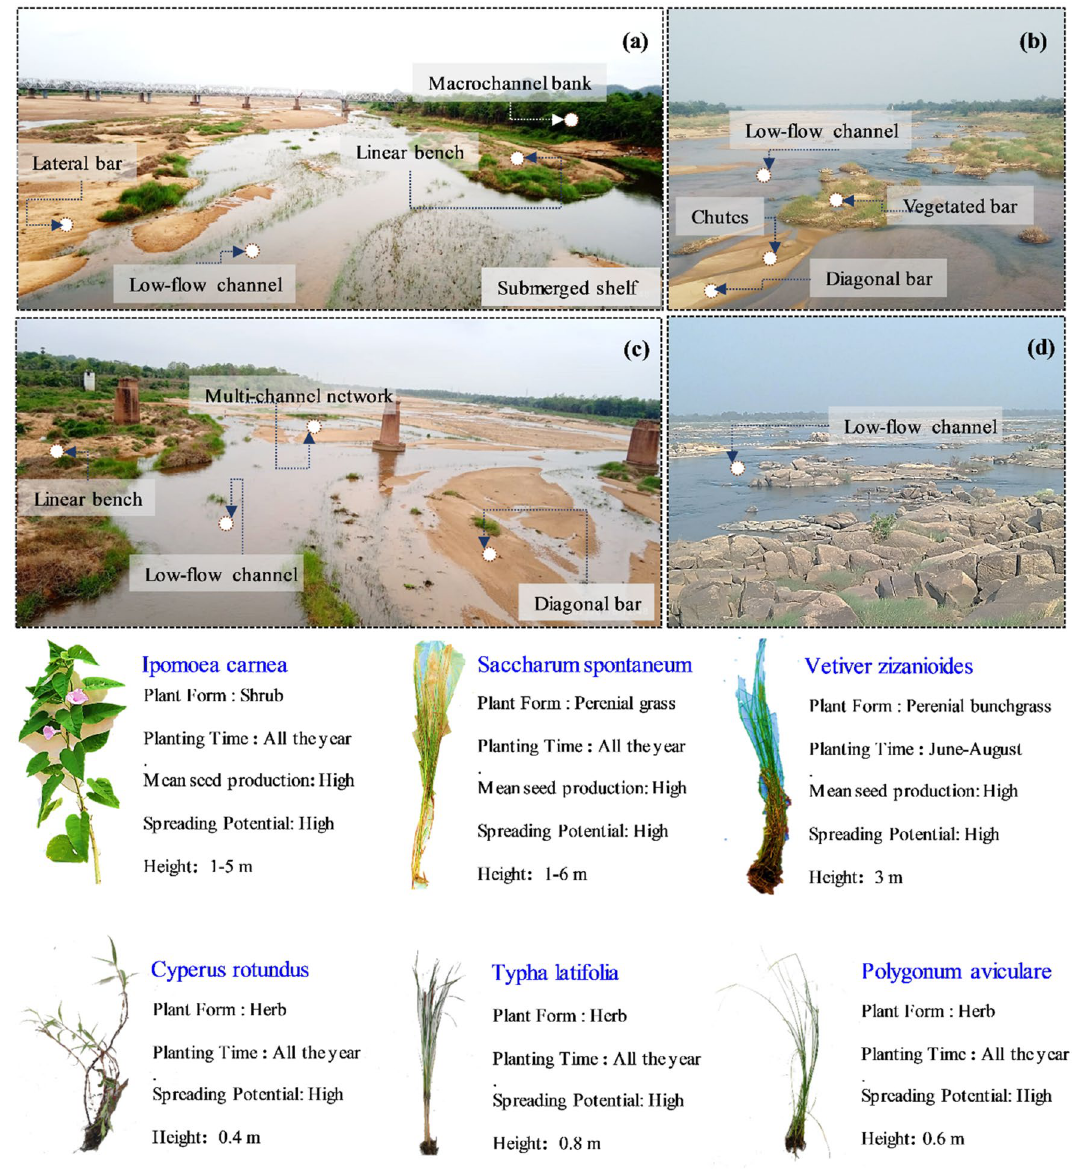
Figure 2. Field photographs showing the presence of instream and floodplain geomorphic units in the Ong-Tel paired catchment, ( a , c ) macrochannel banks and instream vegetated geomorphic units in the Ong River, and ( b , d ) prevalence of diagonal bars and defined low-flow channel in the Tel River. The dominant instream and riparian vegetation cover details are also shown along the two